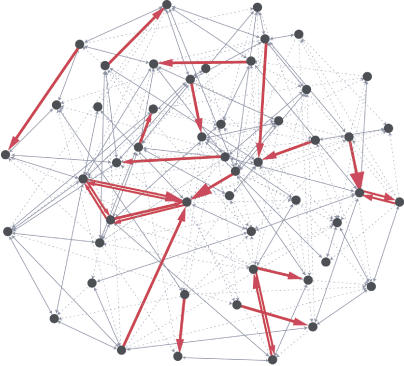
Statistically Reconstructed Network of 50 Layer 5 Pyramidal Neurons Illustrates That Stronger Connections form a Skeleton Immersed in a Sea of the Weaker OnesDetails of statistical reconstruction are given in Materials and Methods. For illustrative purposes, neurons are arranged so that strongly interconnected nodes are close by. Dotted arrows are weak (<1 mV) unidirectional connections; solid arrows are weak bidirectional connections. Red arrows are strong (>1 mV) unidirectional connections with arrow size indicating the strength. Red arrows with double lines are strong bidirectional connections.